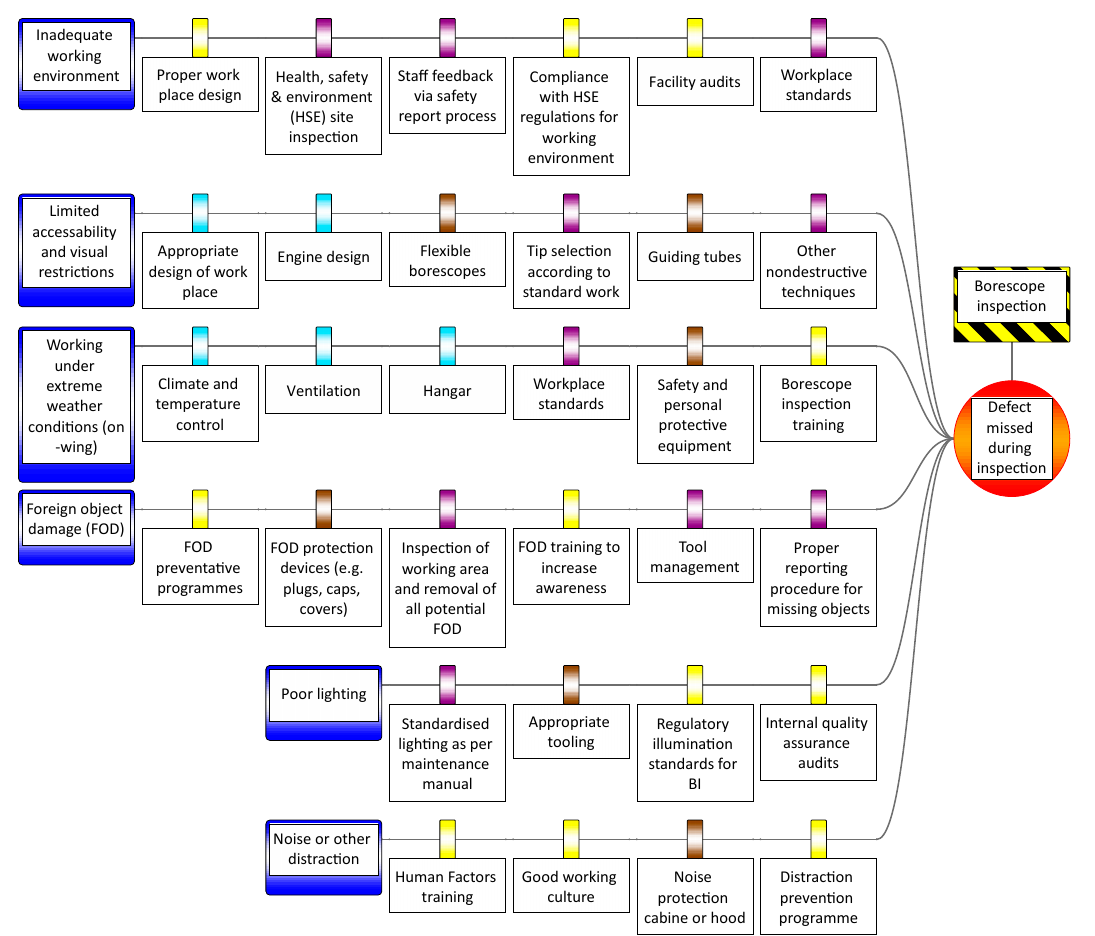
Figure 17. Mother Nature-related threat paths with barriers.